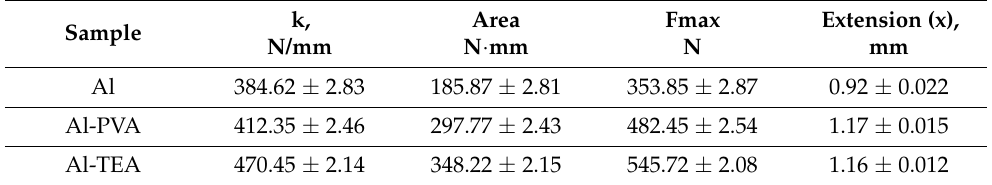
Table 4. Values of k, A, Fmax and the extension for the blank and Al-modified plates.